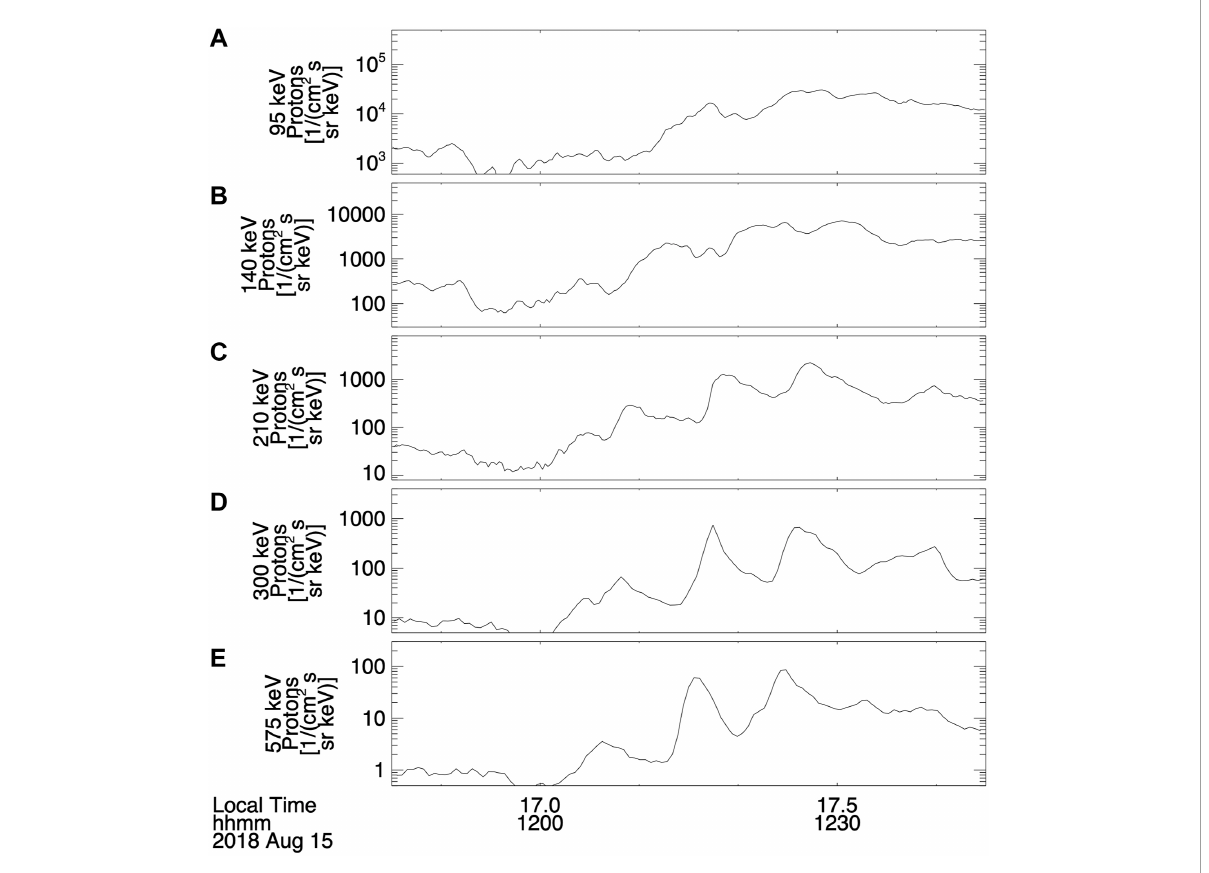
the change in the spectra at MMS, and on the right, showing the change in the spectra at Van Allen Probes: the blue, green, and yellow lines show the same events on each plot, and the red and orange lines on the plot on the right are data from the two Van Allen Probes and both correspond to the red line on the